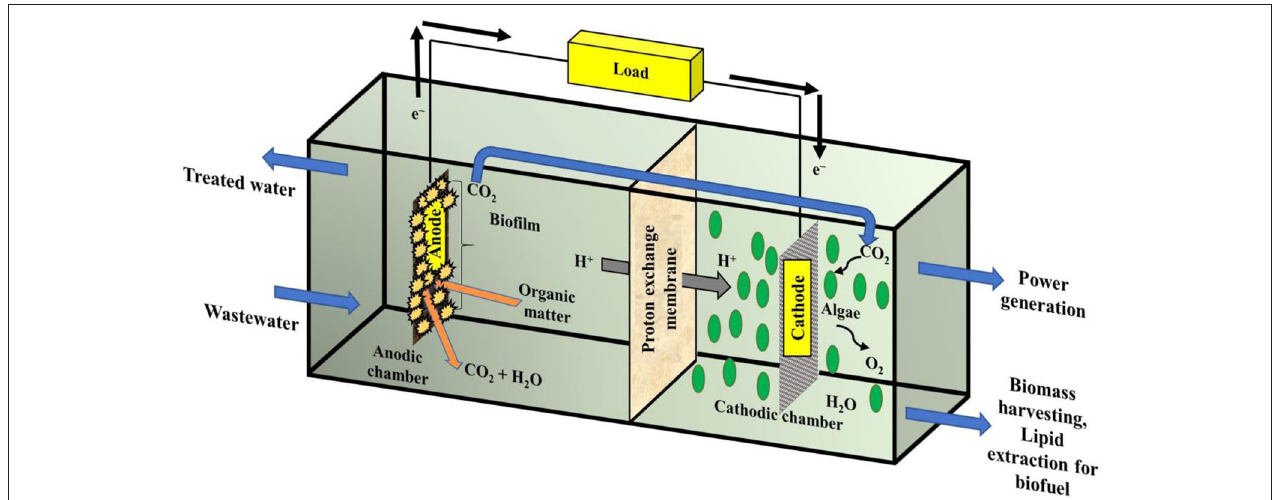
FIGURE 4 | Bioenergy production through microbial carbon capture cell using algae.